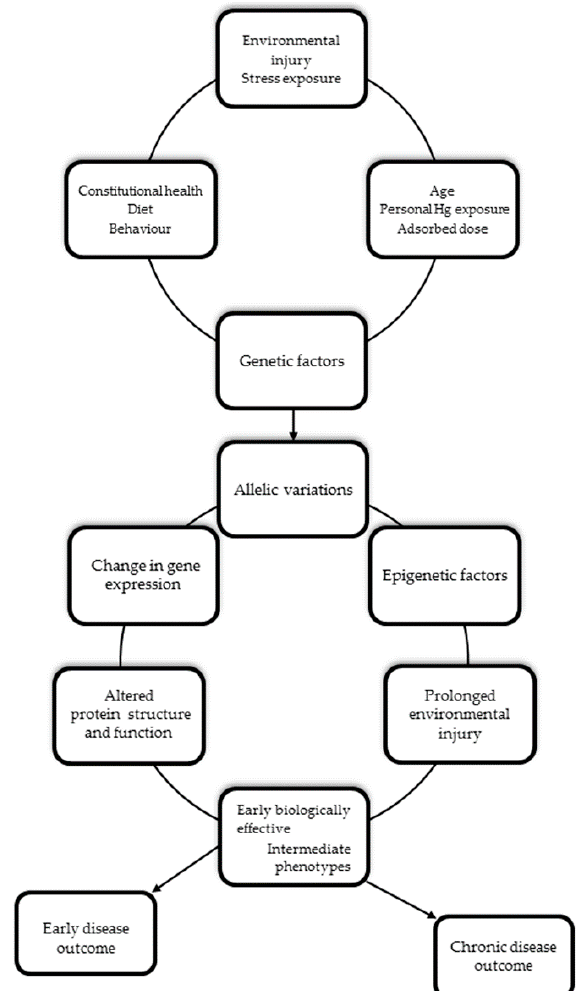
Figure 1. The expanded environmental-genomic heuristic model related to mercury. Genetic and environment interactions contribute to the development of pathological conditions. Allelic variation underlies functional differences in expression or activity of involved gene products and activation of associated biological pathways, leading to manifestation of early or late phenotypic variations. With prolonged exposure to environmental stimuli that also induce long-term epigenetic process on a background of genetic susceptibility, altered gene expression profiles enable the transition of an intermediate state to a chronic pathological state